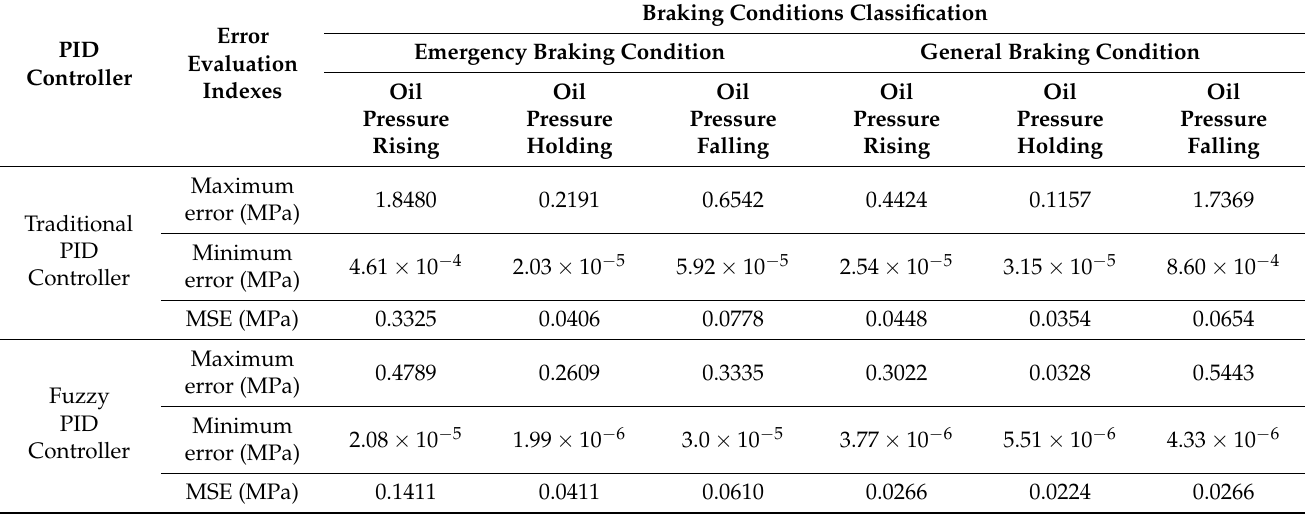
Table 5. The experimental results of oil pressure following